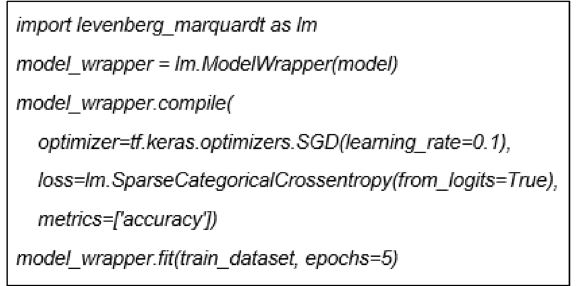
Figure 3. Implemented LM algorithm using Python.